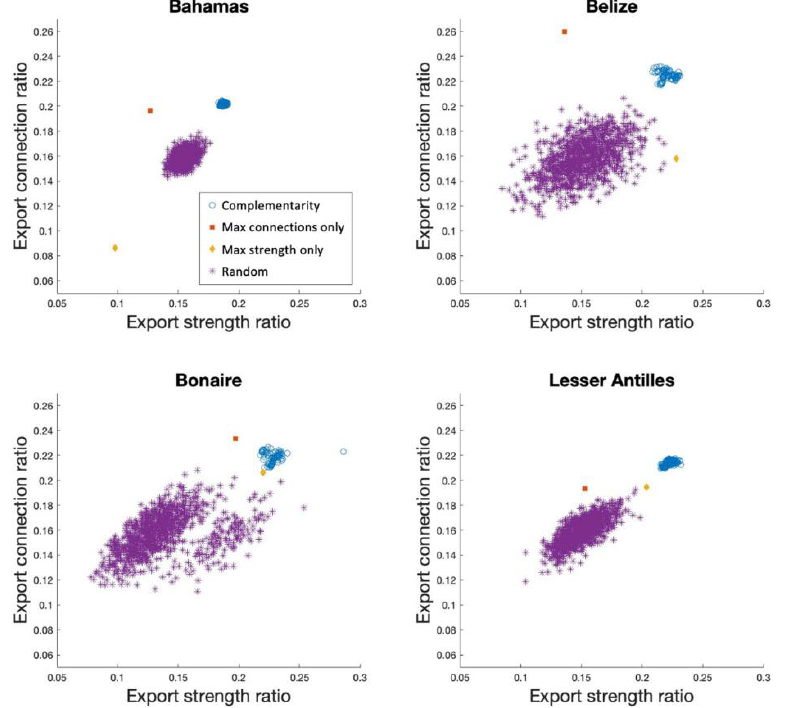
Figure 2. Scatter plots depicting the strength and quantity of connections from MPA systems to the unprotected component of the entire network, at 20% MPA coverage. Export strength ratio refers to the strength of larval flow from MPA systems to unprotected sites, as a fraction of total larval flow across the respective region. Export connection ratio refers to the number of connections from MPA systems to unprotected sites, relative to total number of connections across all sites in the region. MPA systems in the top right quadrant are both strong larval exporters to unprotected areas and connected to many unprotected areas. Again, Complementarity refers to the algorithm MPA systems ( n = 1000); “Max connections only” and “Max strength only” refer to optimising fixed connectivity metrics ( n = 1); and Random refers to randomly selected MPA systems ( n = 1000).